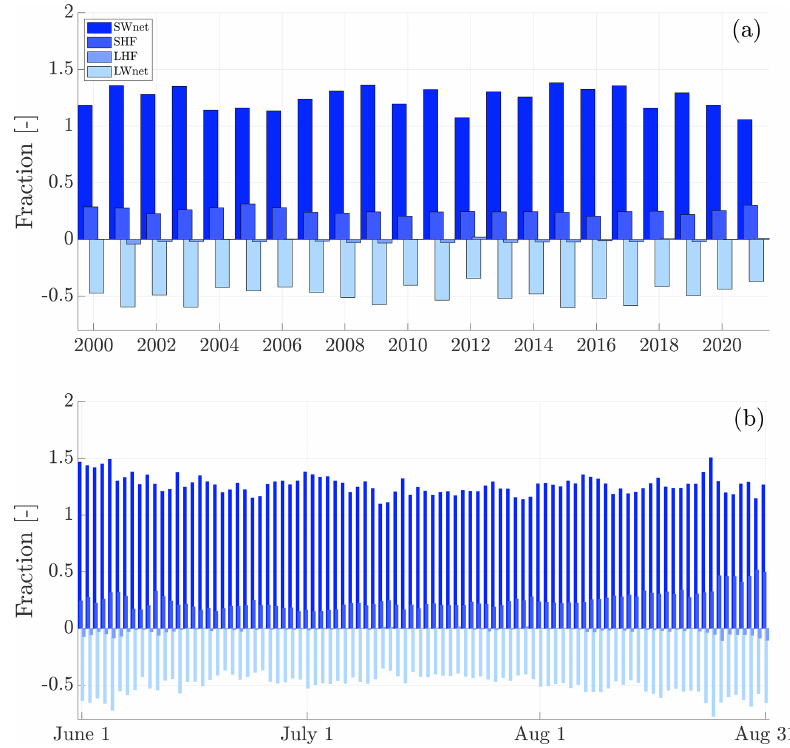
Figure 6. Fractional contributions of energy fluxes to meltwater production over the bare-ice zone: (a) annual averages for 2000–2021 and (b) seasonal averages for JJA.